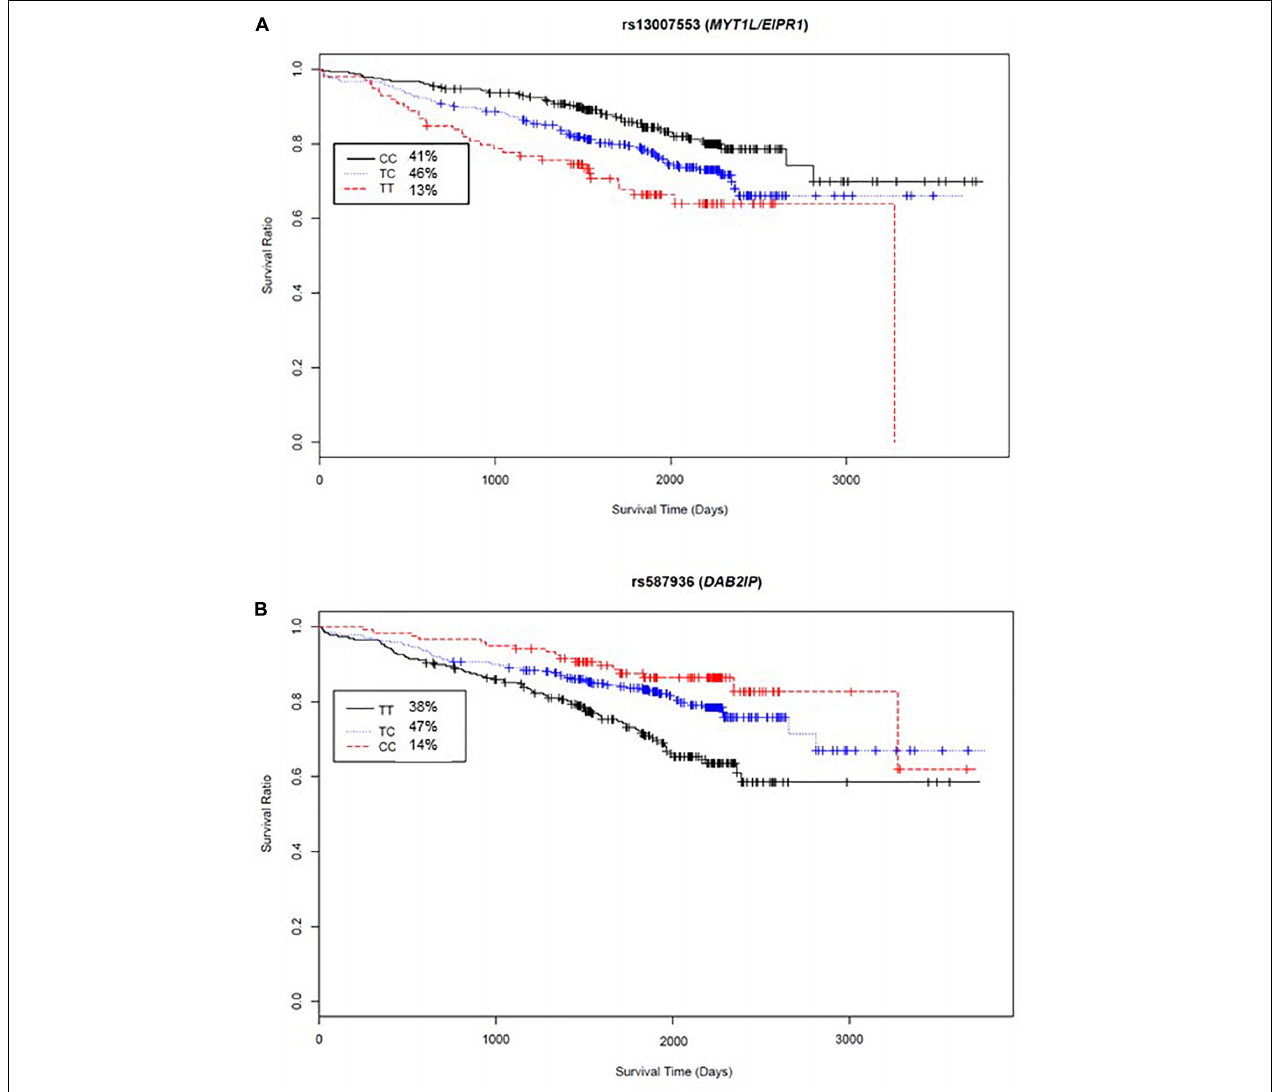
FIGURE 3 | Kaplan-Meier curves for top two meta-analyses genome-wide SNP exemplars. X -axis, days from enrollment to death or last follow up; Y -axis, probability of survival; inset box, genotype frequencies. (A) Survival curve by rs13007553 genotype indicates 1.47 times increased hazard of all-cause mortality for each addition of the minor allele (T nucleotide). (B) Survival curve by rs587936 genotype indicates reduced hazard of all-cause mortality with each addition of the minor allele (C nucleotide) (HR 0.65).